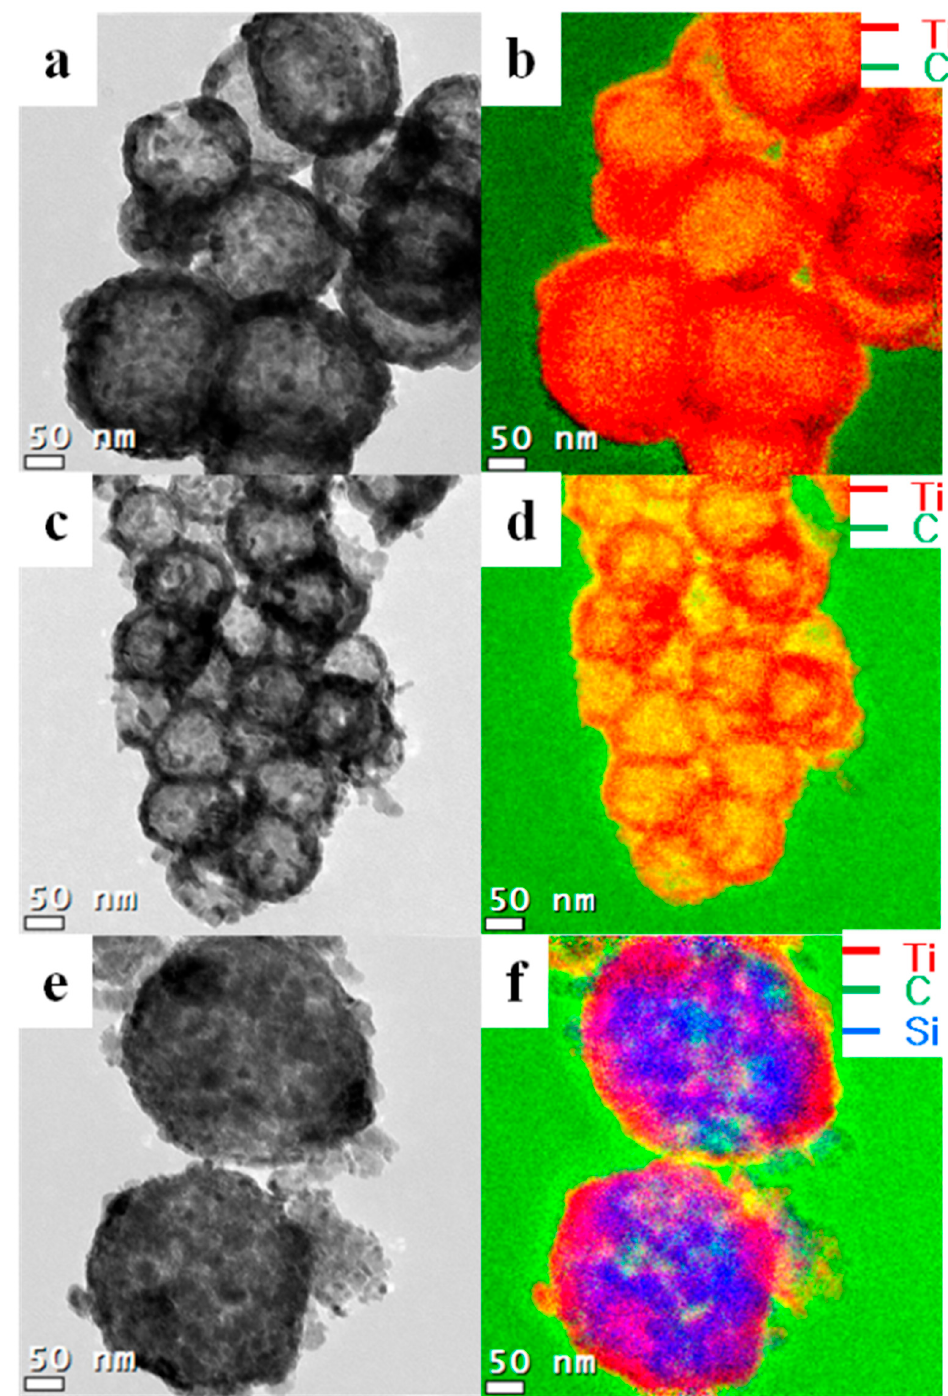
Figure 5. TEM images of core-shell-structured titania spheres ( a ) CS1, ( c ) CS2, and ( e ) CS3. Electron energy loss spectroscopy (EELS) mapping of synthesized titania ( b ) CS1, ( d ) CS2, and ( f ) CS3. The red lines show the Ti atoms, green lines show the carbon atoms, and blue lines show the silicon atoms.